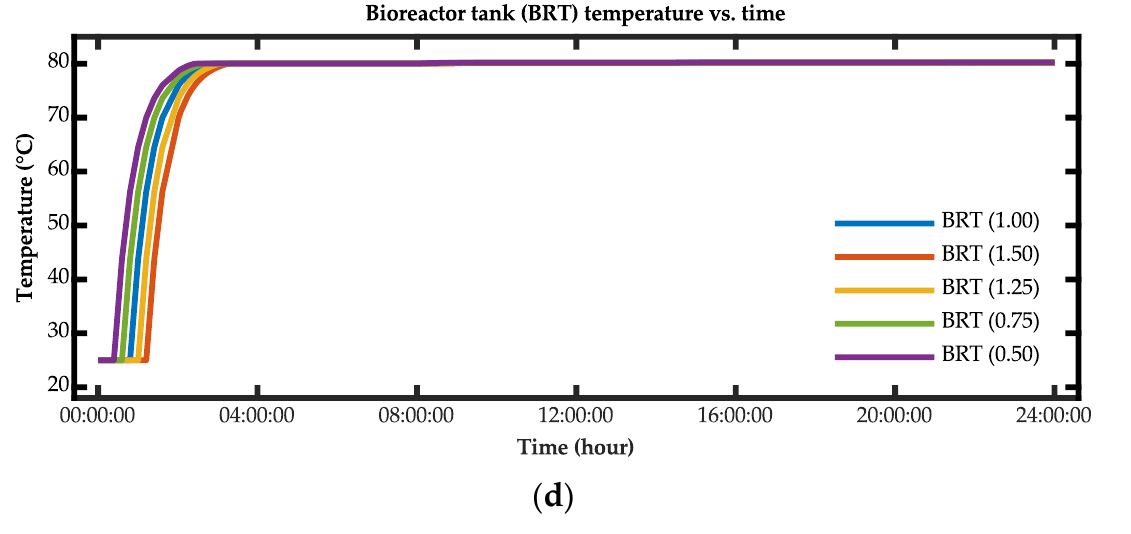
Figure 17. Simulation results for the ( a ) feed-mixing tank volume versus time, ( b ) feed-mixing tank temperature versus time, ( c ) bioreactor tank temperature versus time, and ( d ) bioreactor tank volume versus time.